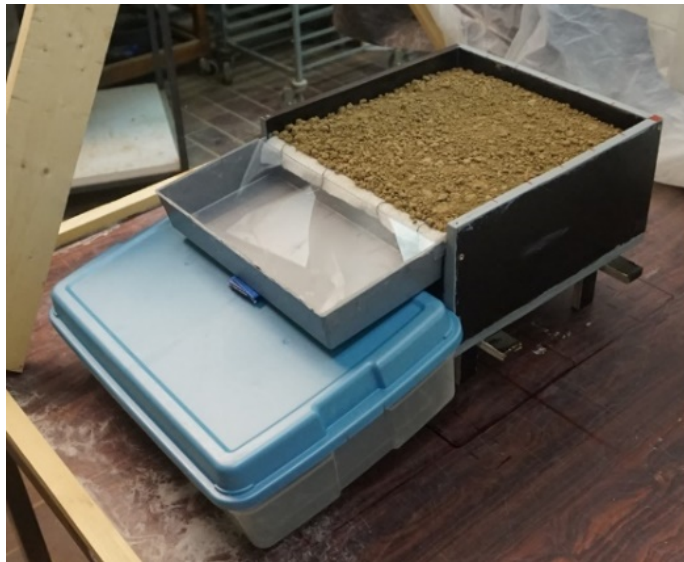
Figure 2. Illustration of a soilbox used during the experiments.